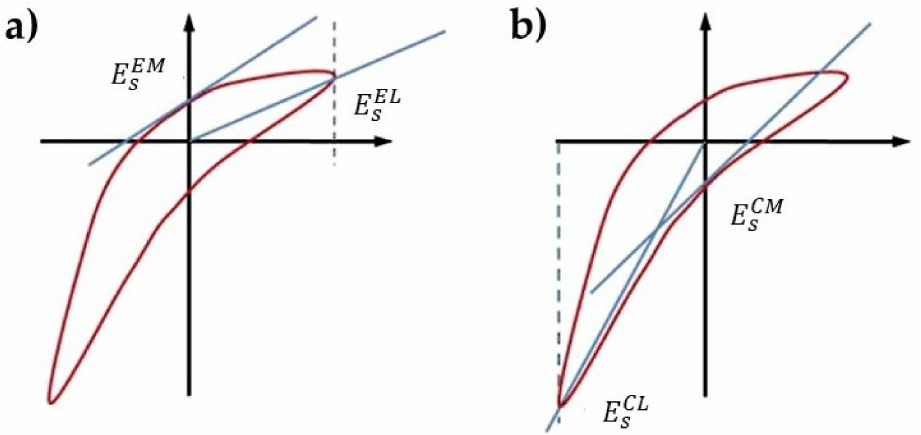
Figure 6. Definition of minimum and large-strain moduli. ( a ) Minimum and large deformation dilational moduli in extension. ( b ) Minimum and large deformation dilational moduli in compression. Adapted from Sagis and Fischer [113], with permission from Elsevier, Copyright